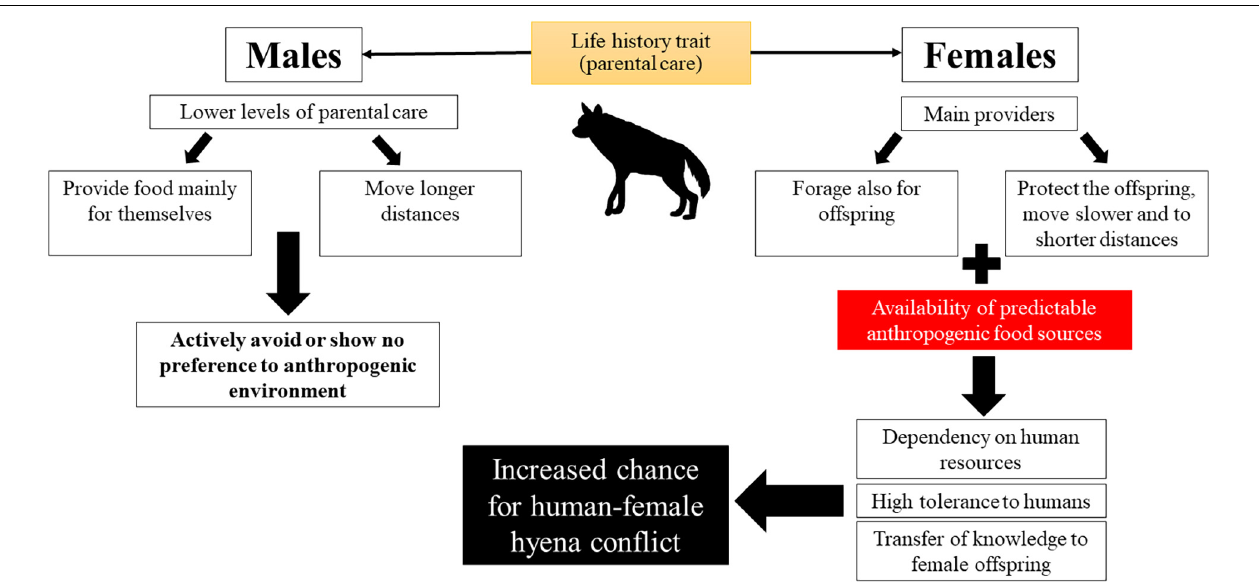
FIGURE 7 | A conceptual model for the combined effects of adding anthropogenic food subsidies on males and females striped hyenas’ behavior and risk of human-wildlife